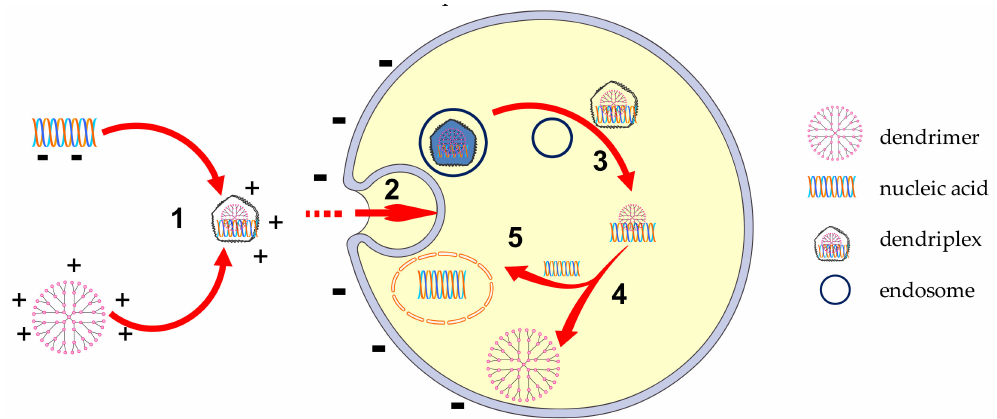
Figure 7. Mechanism of gene transfection through cationic dendriplexes. (1) nucleic acid condensation with dendrimers forming stable dendriplexes; (2) cellular uptake of dendriplex; (3) endosome escape of dendriplex; (4) the release of the dendriplex components; (5) the entrance of the nucleic acid in the nucleus. Adapted from [13], published by Elsevier, 2020. PAMAM dendrimers [177–179], phosphoric dendrimers [180,181],